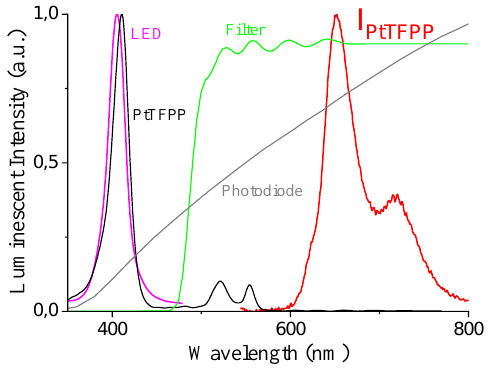
Figure 3. LED emission spectrum, PD response, luminophor absorption and emission, and optical filter spectral